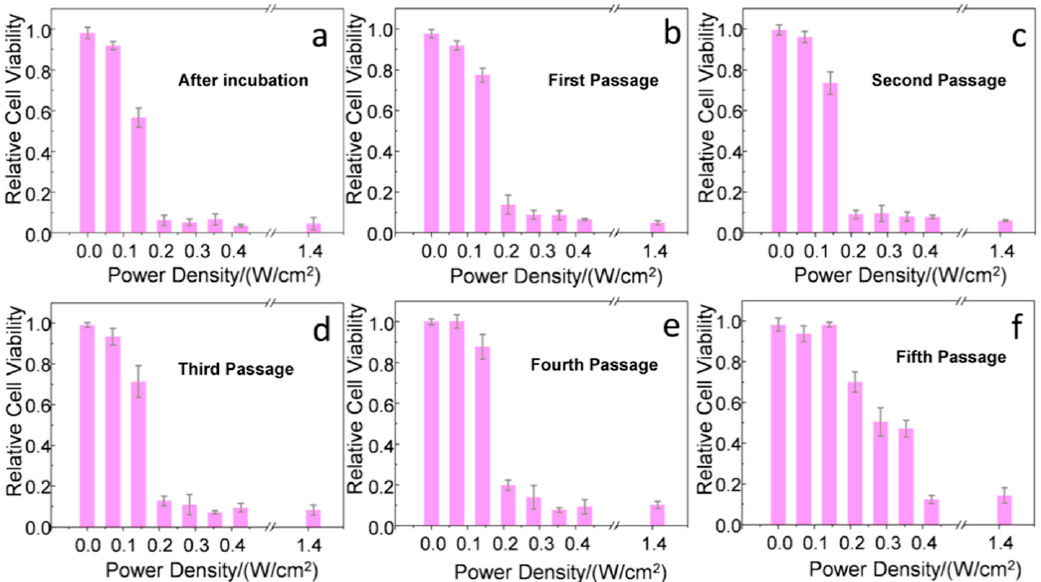
Figure 4. Cell viability as a function of the applied fs laser power density (3 independent samples were tested and averaged at each power density; the error bars show the standard deviation of the relative cell viability). ( a ) After incubation with Au NSs, we observed an important killing rate using laser power densities above 0.21 W/cm 2 . Similar results were obtained after the first ( b ), second ( c ), third ( d ), and fourth ( e ) cell passage, with small differences of 10–20% of cell survival. After the fifth passage ( f ), a laser power density of at least 0.42 W/cm 2 was required to obtain significant cell killing rates.